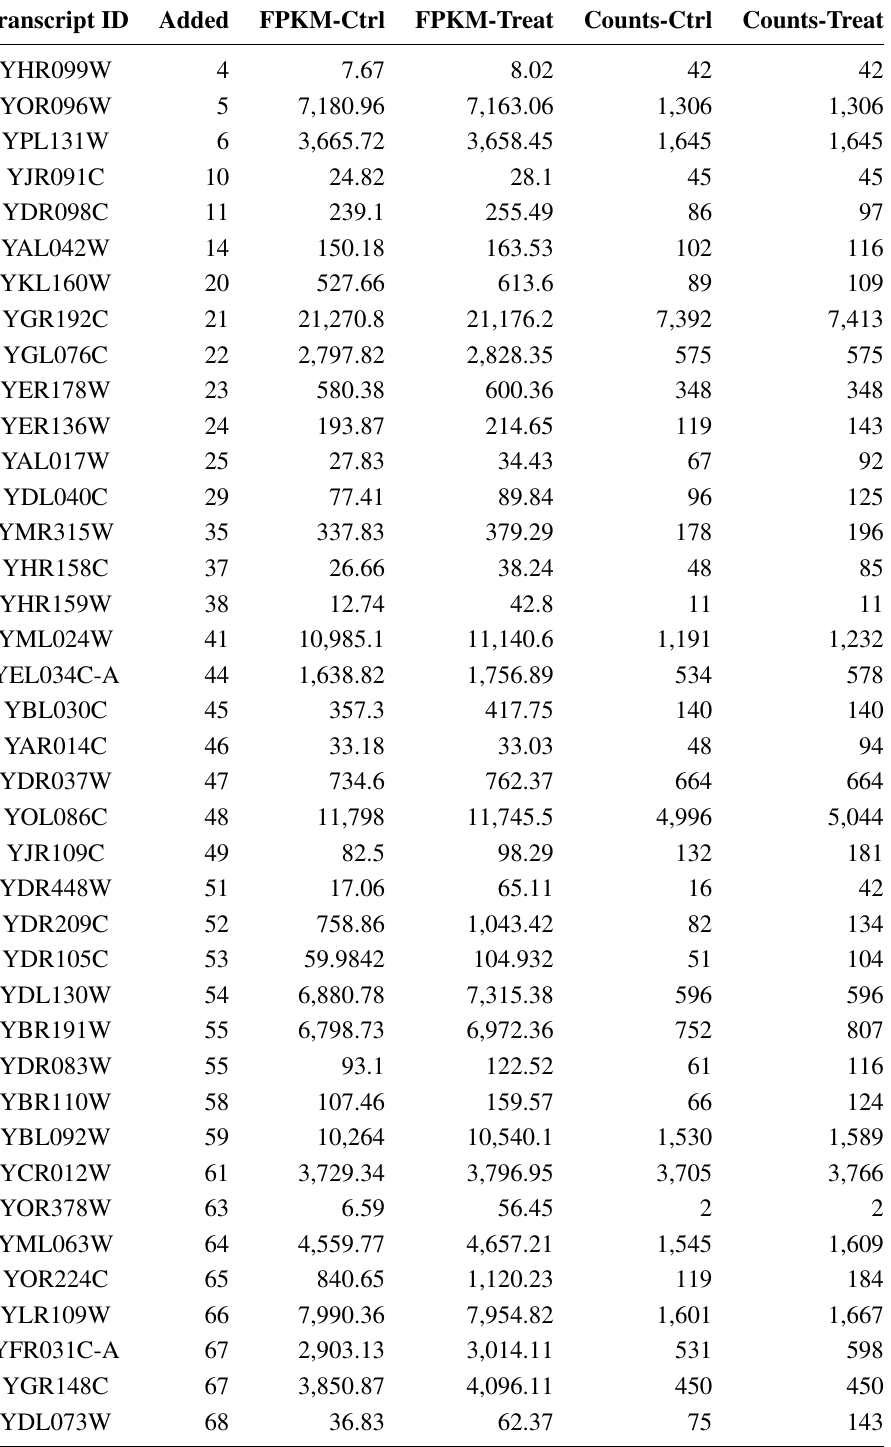
Table 1. Benchmark dataset for software comparison. The 79 artificially modified transcripts in RNA-seq dataset on S. cerevisiae [16] used to generate two artificial datasets (denoted here as Ctrl and Treat) for our software performance comparison study. For each transcript listed in the first column, the specific number of reads listed in the second column is manually added to force differential expression in the Treat group. All the remaining transcripts are left unchanged. Last two columns provide the observed counts as reported by the